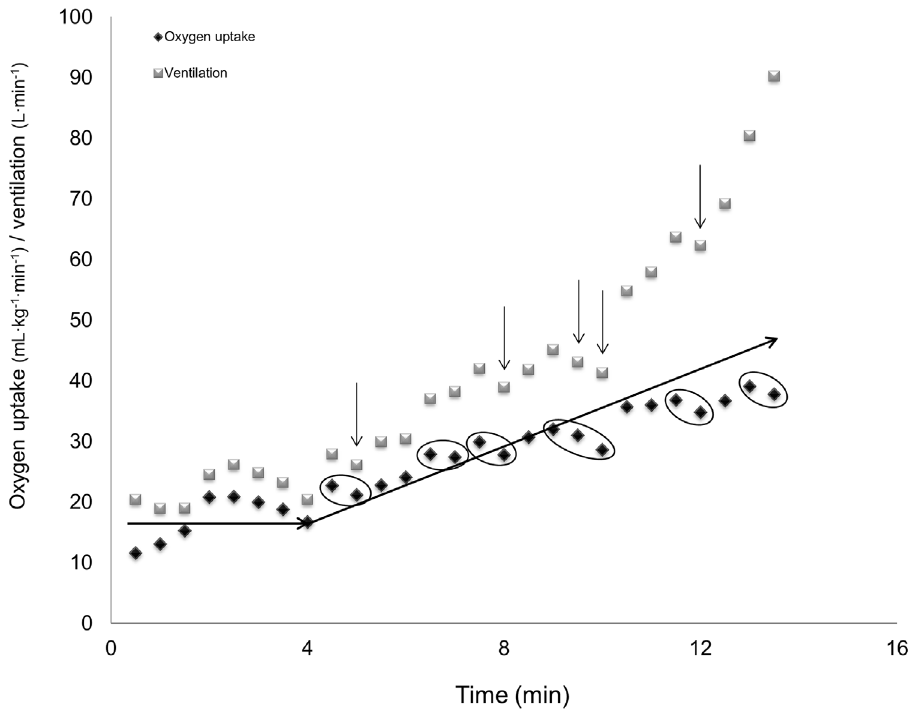
Figure 2. Oxygen uptake (mL N kg 2 1 N min 2 1 ) and minute ventilation (L N min 2 1 ) from table 3 plotted against time (min). The arrows’ pointing downward indicates a drop in ventilation followed by a levelling off in VO 2 marked by a circle. The right pointing arrow indicates the expecting increase in VO 2 .